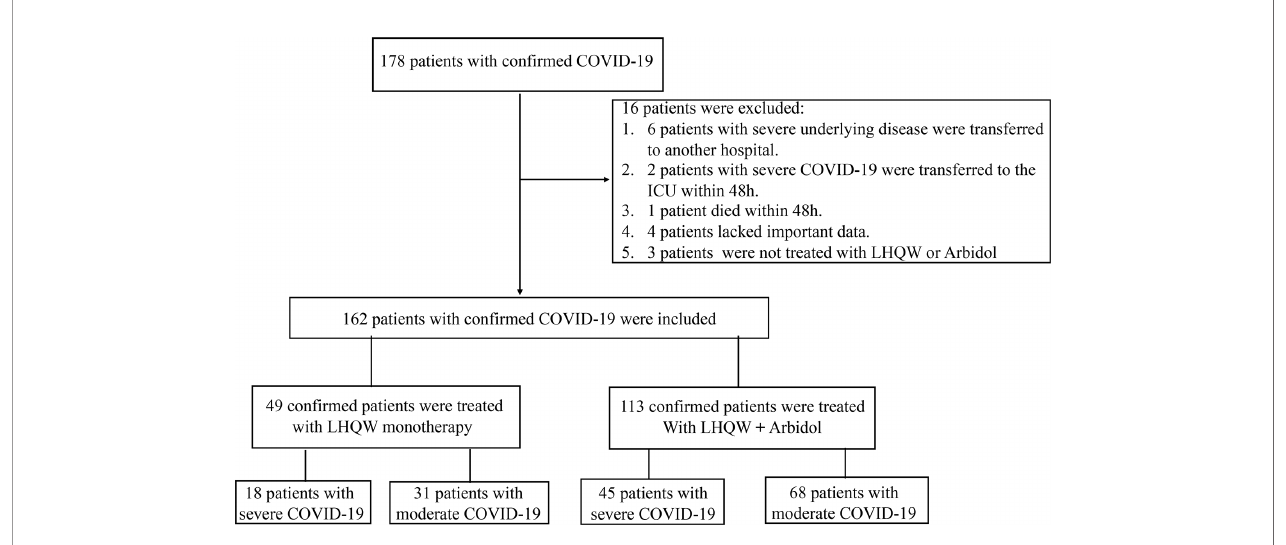
FIGURE 1 | The fl ow diagram of this